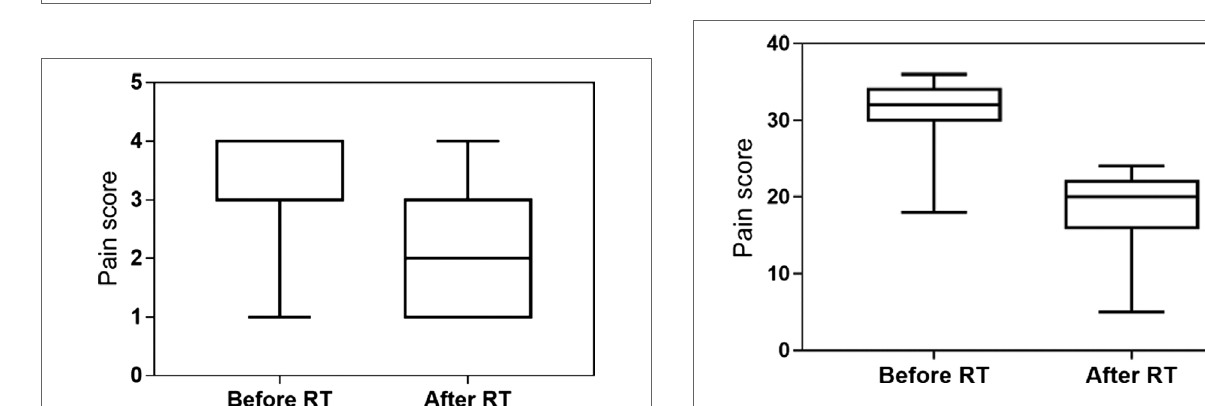
FigUre 2 | Lameness score evaluated at presentation and 3 weeks after low-dose radiation therapy in 23 dogs. The median lameness score decreased from 4 (range 2–5) to 3 (range 0–3) after RT ( P <